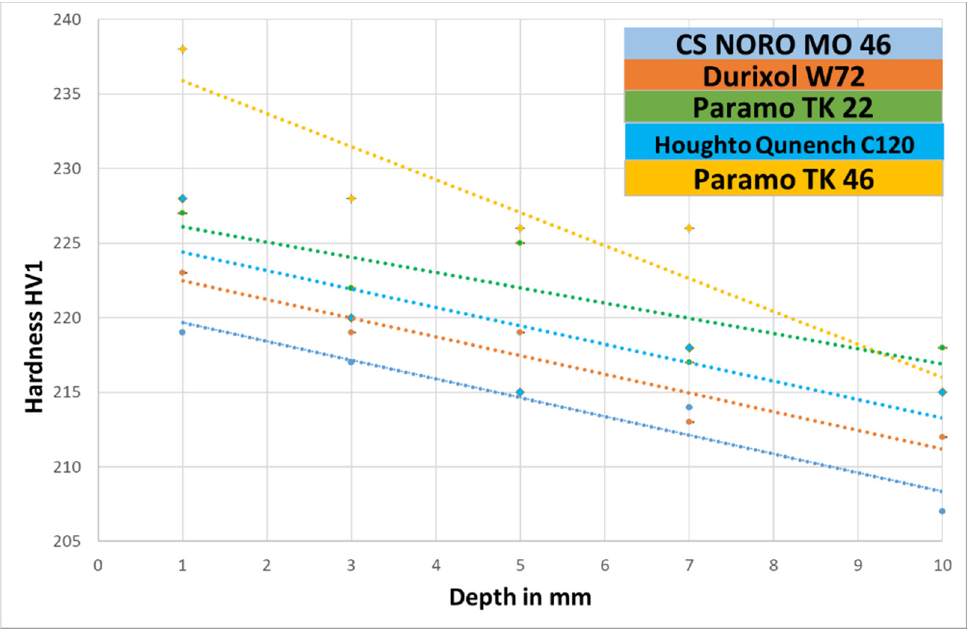
Figure 1. Hardness profile for individual oils.